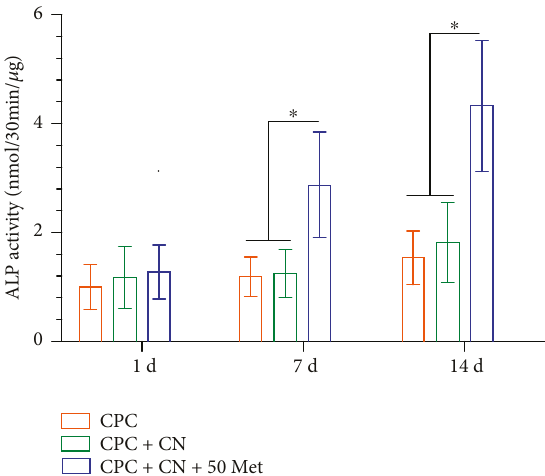
Figure 4: Alkaline phosphatase (ALP) assay. ALP activity was measured at days 1, 7, and 14. A signi fi cant increase in ALP activity was observed in the CPC + CN+ 50Met group compared with the CPC control and CPC +CN control ( ∗ P < 0 05 ). Data represent mean ± SD of three independent experiments with